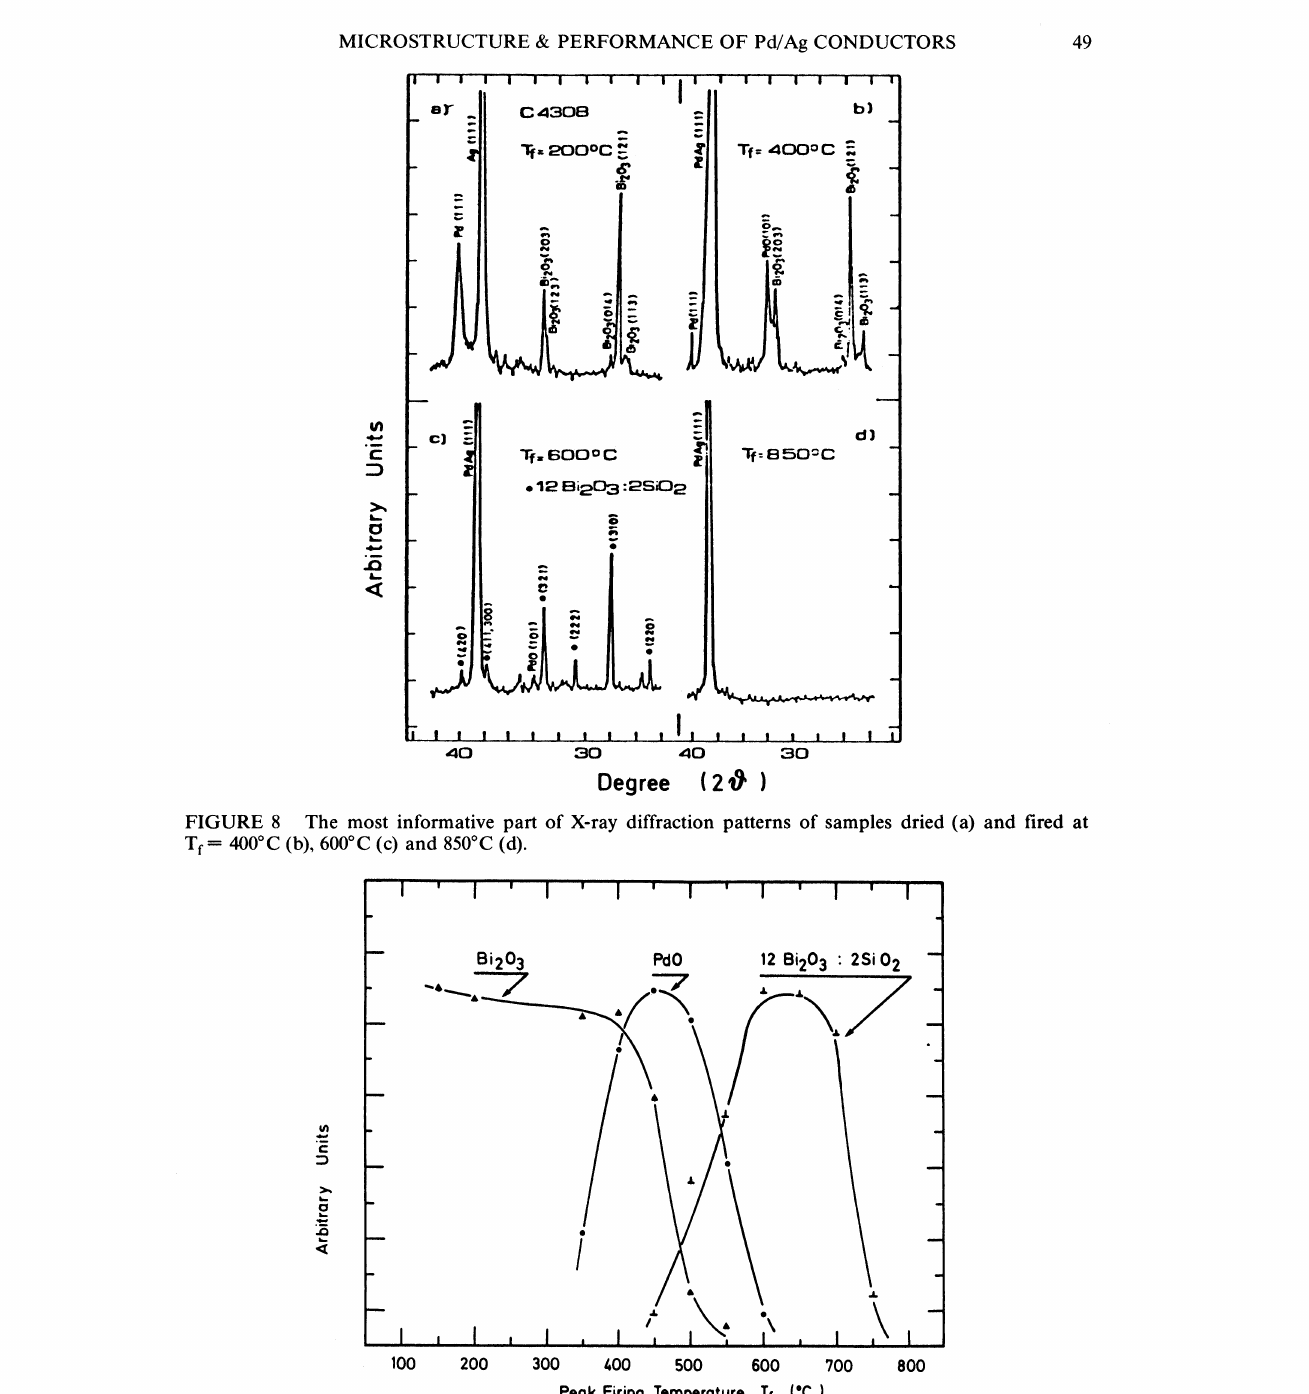
Relative intensity of some phases present in XRD patterns of samples fired at different peak temperatures